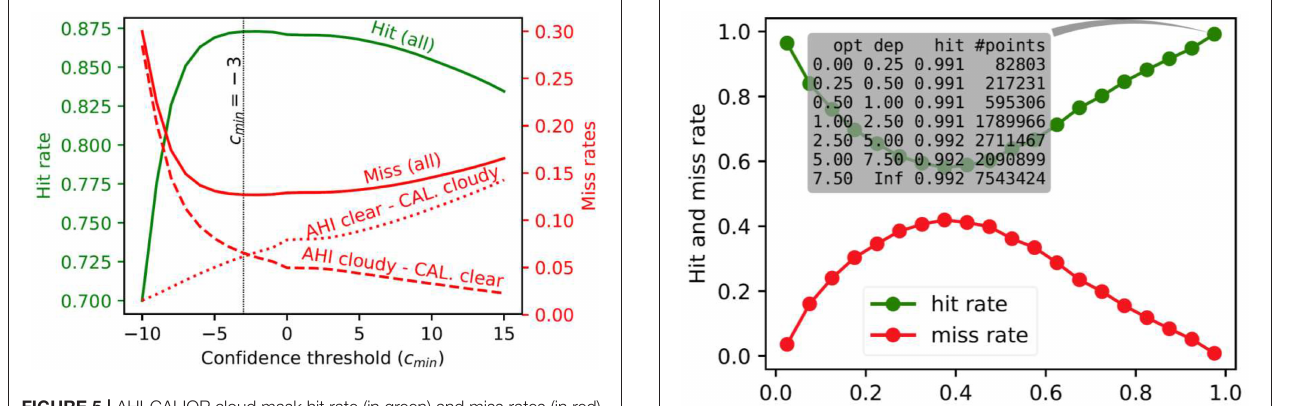
FIGURE 5 | AHI-CALIOP cloud mask hit rate (in green) and miss rates (in red) as functions of confidence threshold ( c min , see text). At the neutral point, c min = − 3, the clear-cloudy and cloudy-clear rates reach equality while the hit rate reaches its maximum and miss rate reaches its minimum. Data was collected over both land and water for the region (110 ◦ E , 155 ◦ E , 10 ◦ S , 45 ◦ S ) from 6th Jul 2015 to 30th Jun 2016.